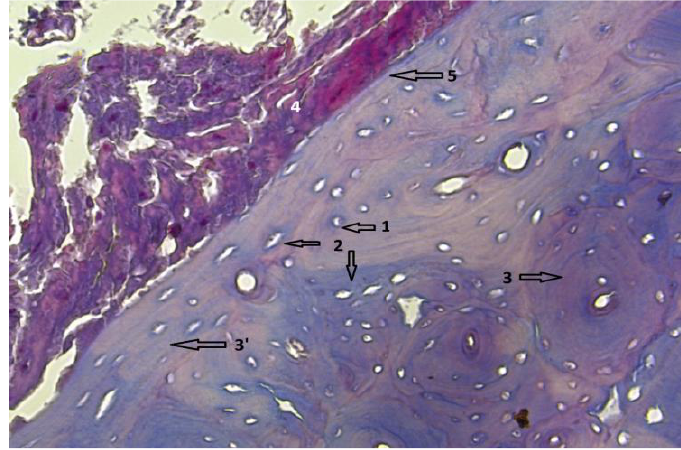
Figure 23. Bone tissue, Trichrome Masson stain; 20 × 40 magnitude. 1-Viable bone cells with intracytoplasmic nucleus, 2-Collagen fibers, 3-Normal bone tissue arranged in parallel line, 5-The bone-alloy interface.